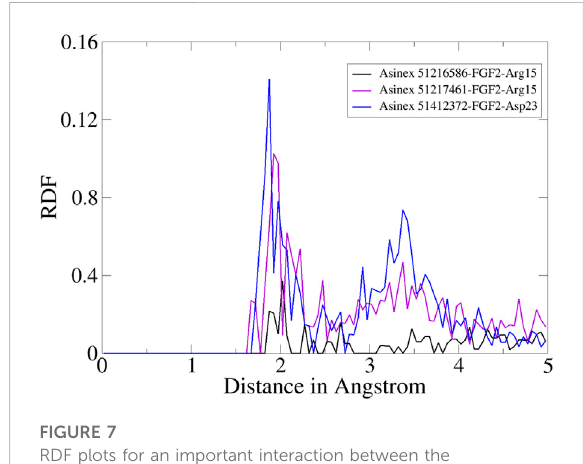
FIGURE 7 RDF plots for an important interaction between the compounds and